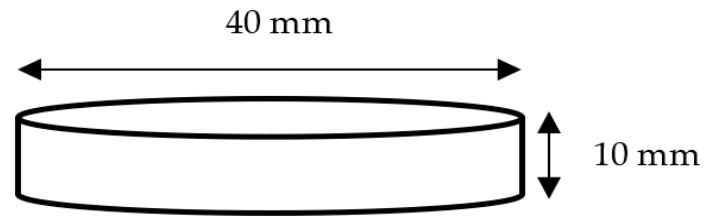
Figure 1. The wheat and rice dough sample measurement for texture profile analysis (TPA).